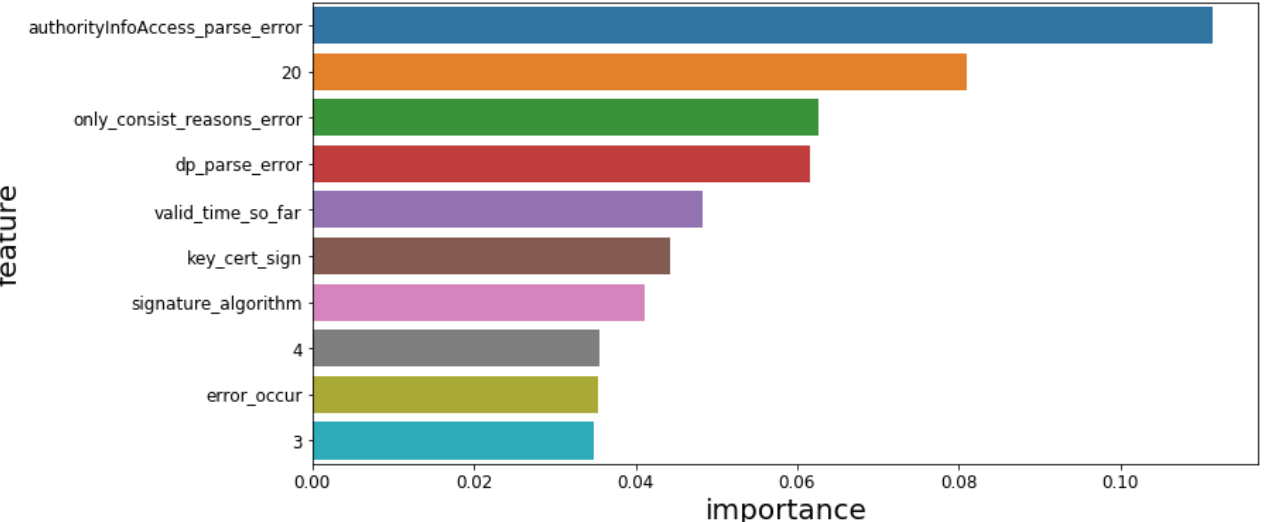
Figure 5. Important features of XGBoost.